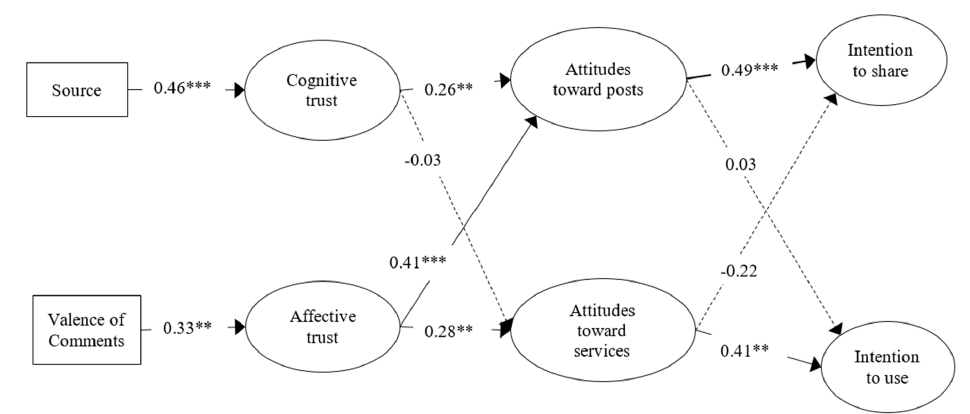
Figure 4. Model of Source and Valence of Comments on Behavioral Intentions. The model includes effects of control variables, which are not displayed. Indicators of each latent variable are not displayed. Dashed lines indicate non-significant paths. ** p < 0.01. *** p < 0.001. Posts from a professional source had a significant positive influence on cognitive trust ( β = 0.46, p < 0.001), thus supporting H1.